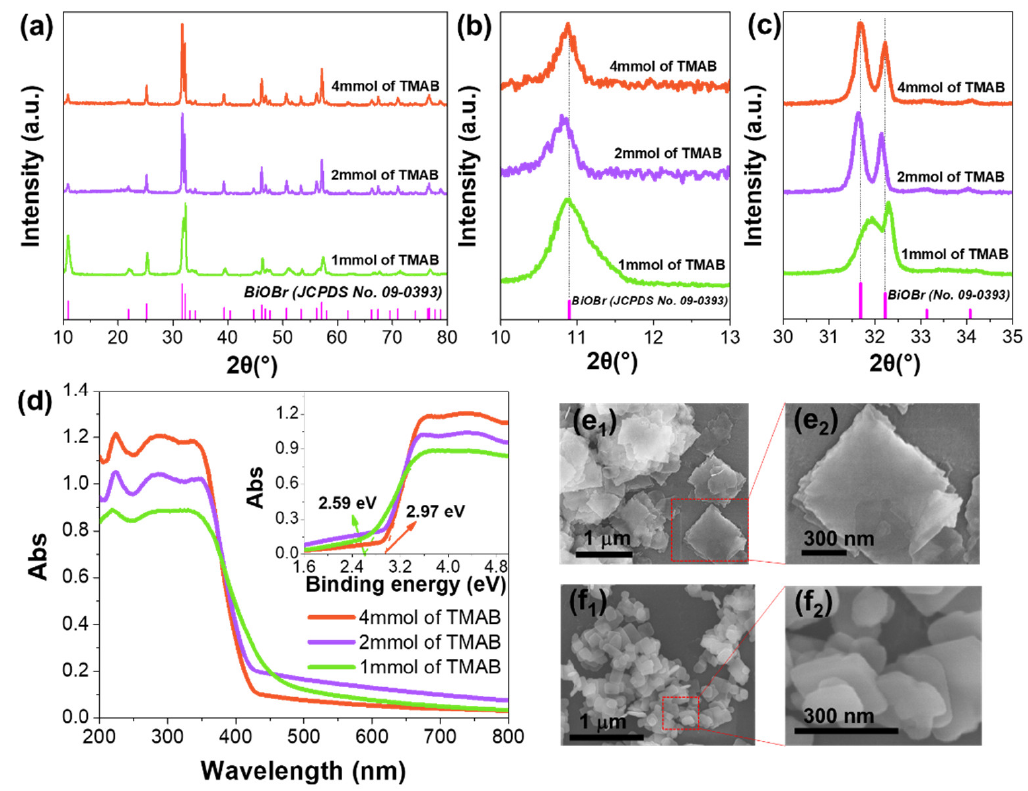
Figure 3. Comparison of products prepared by the addition of different molar reactants, ( a ) XRD patterns, corresponding enlarged range of ( b ) 10–13 ◦ and ( c ) 30–35 ◦ . ( d ) DRS spectra (inset with corresponding estimated bandgaps). SEM images of ( e 1 ) and ( e 2 ) 1 mmol of TMAB and ( f 1 ) and ( f 2 ) 4 mmol of TMAB.